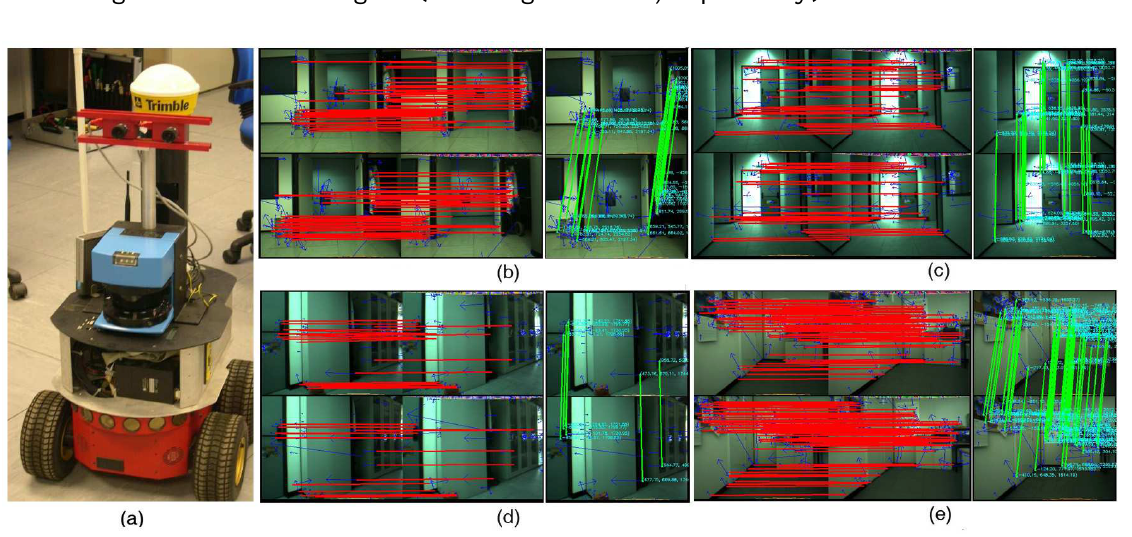
Figure 10. Activmedia P2AT robot used in the experiments. (b–e) four different image pair acquired by the stereo camera across the robot motion in the first test. Stereo and feature matching are shown in the figure (red and green lines,